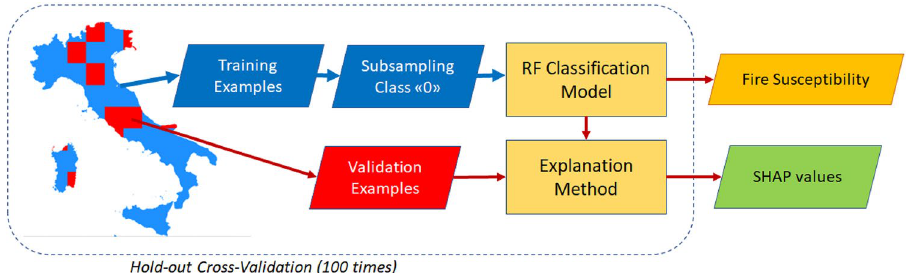
Figure 2. Methodological overview. Environmental, biophysical, and human-related variables are used to model wildfire occurrence over the Italian peninsula. The map was produced by using the plot.raster function from "raster" R